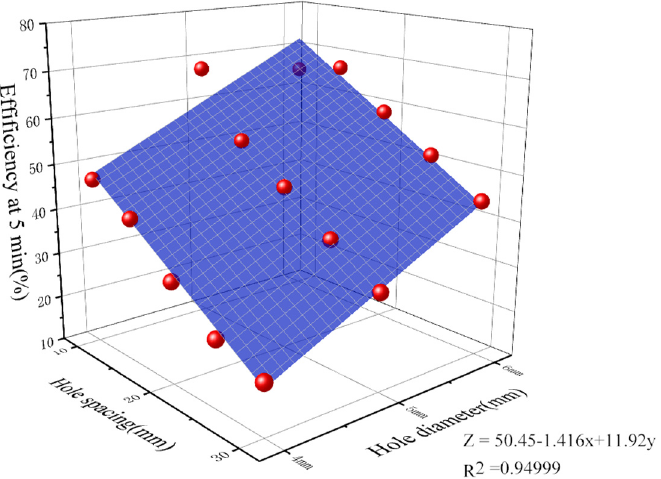
Figure 16. A mathematical relationship between hole diameter, hole spacing, and air curtain effi-